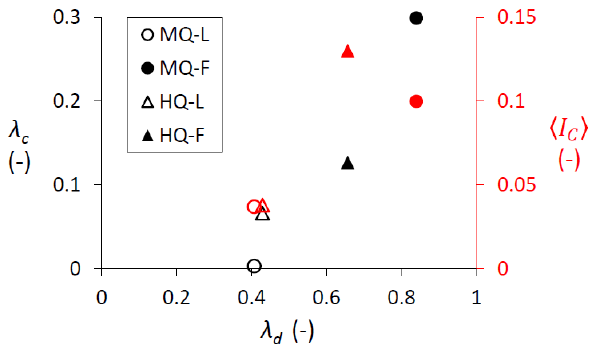
Figure 7. The dependency of the di ff erential concentration λ c on the drag di ff erential λ d ([ C D aH − Figure 7. The dependency of the differential concentration λ c on the drag differential λ d ([ C D aH − C f ] / [ C D aH + C f ]) between the unvegetated and vegetated part of the channel is shown on the left-axis C f ]/[ C D aH + C f ]) between the unvegetated and vegetated part of the channel is shown on the left-axis (black), and the dependency of the laterally averaged fluctuating component of the concentration (black), and the dependency of the laterally averaged fluctuating component of the concentration 〈𝐼 𝐶 〉 (cid:104) I (cid:105) is shown on the right axis (red). MQ = medium flow rate (50 L / s); HQ = high flow rate (83 L / s); is shown on the right axis (red). MQ = medium flow rate (50 L/s); HQ = high flow rate (83 L/s); L = C L = leafless; F = leafless; F = foliated.